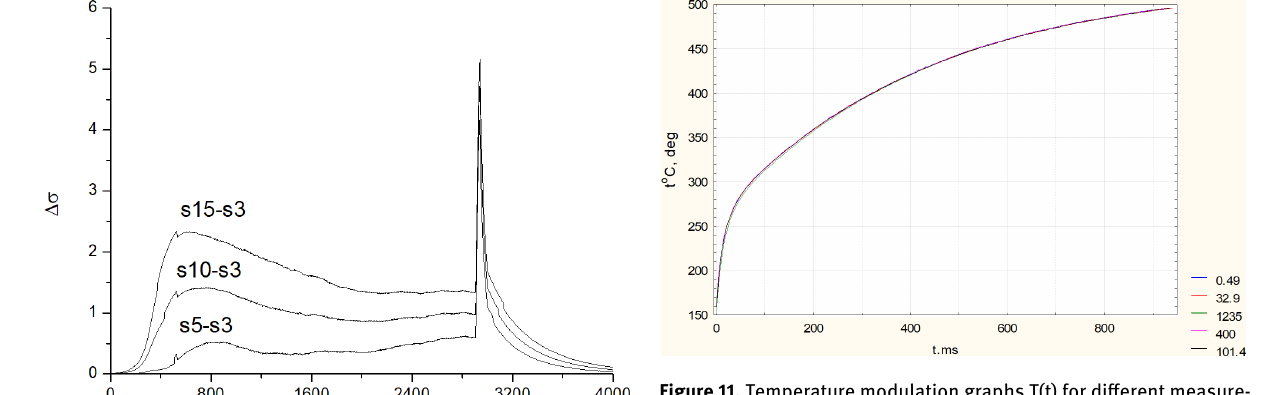
Figure 11. Temperature modulation graphs T(t) for different measure- ments.